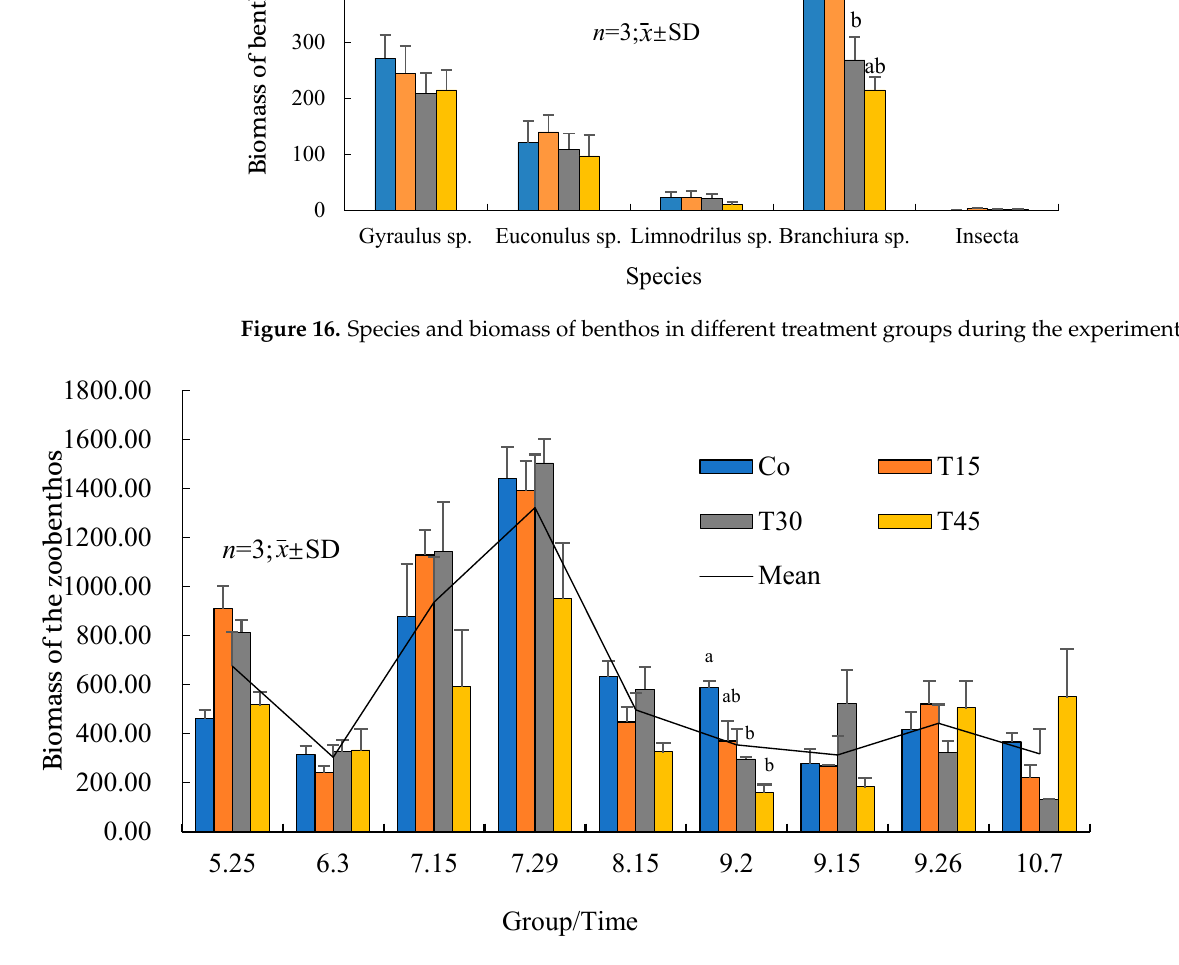
Figure 17. Biomass of the zoobenthos in different treatment groups during the experiment.